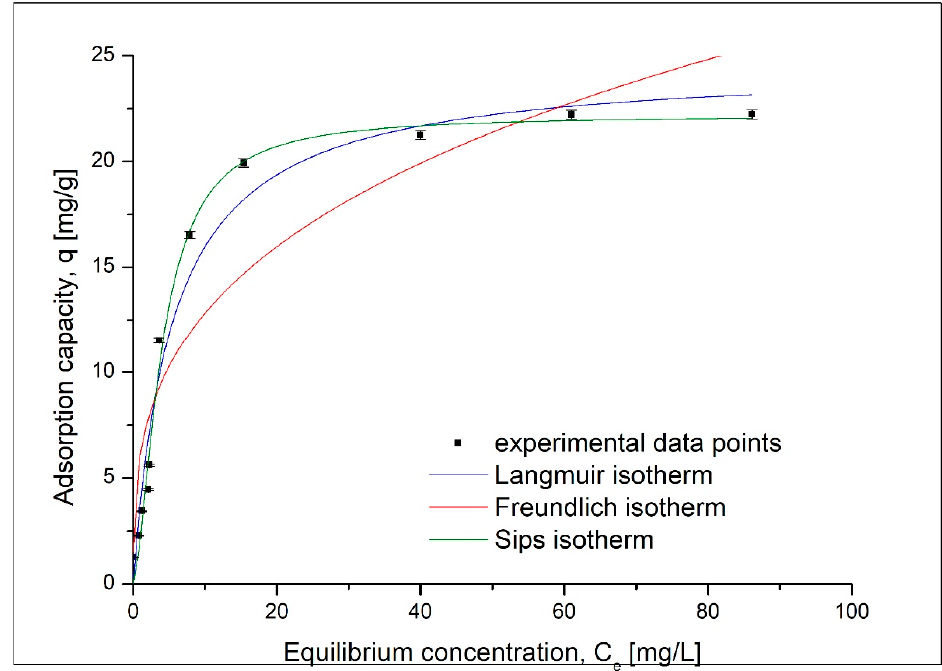
Figure 9. Effect of the initial concentration of Au(III) on sorption capacity.